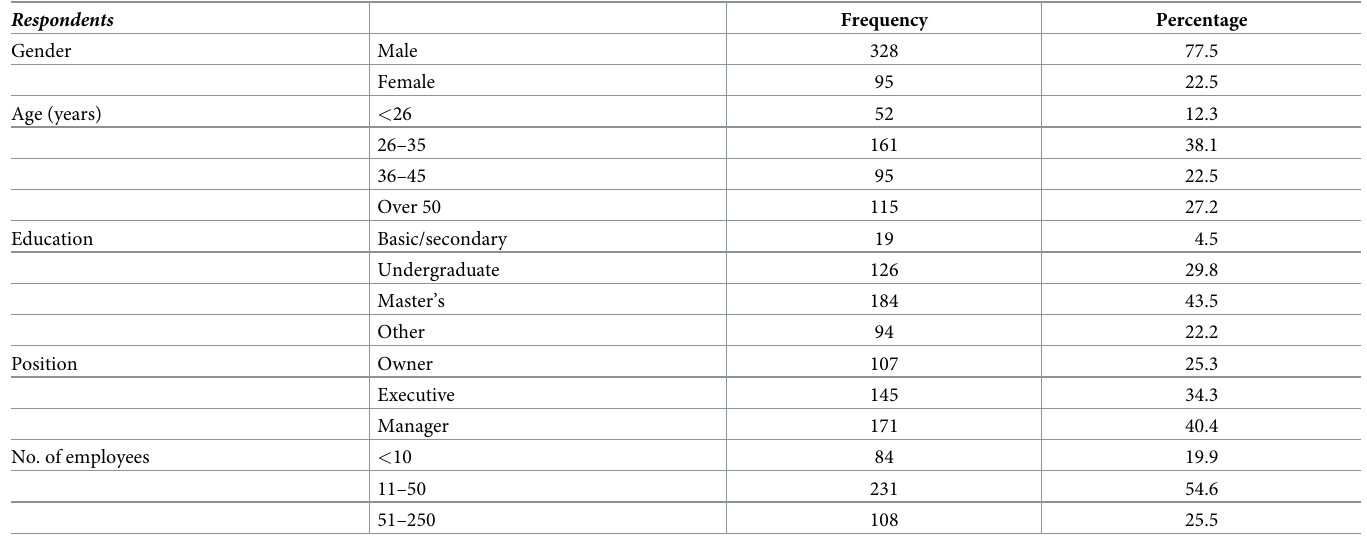
Table 1. Demographic